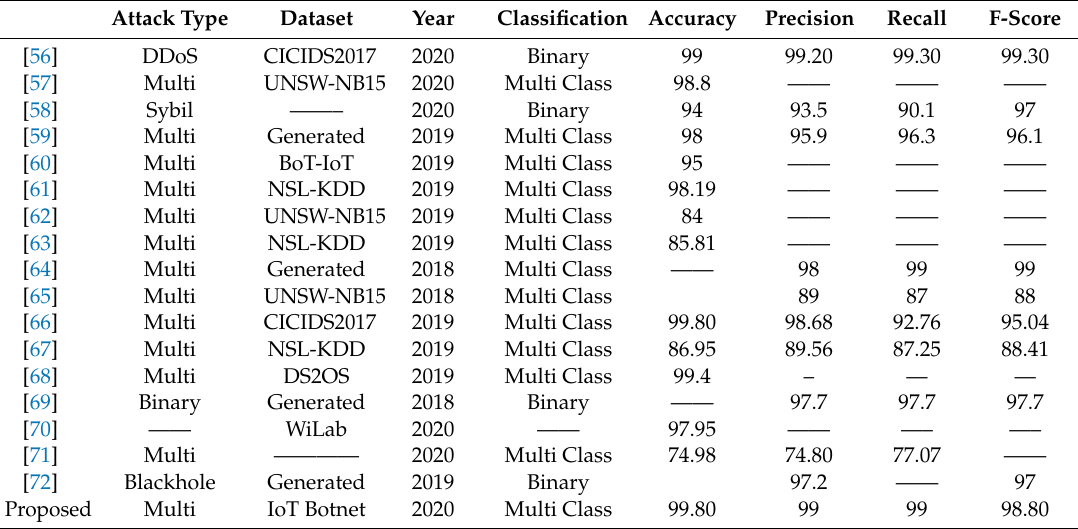
Table 13. Intrusion Detection System IoT